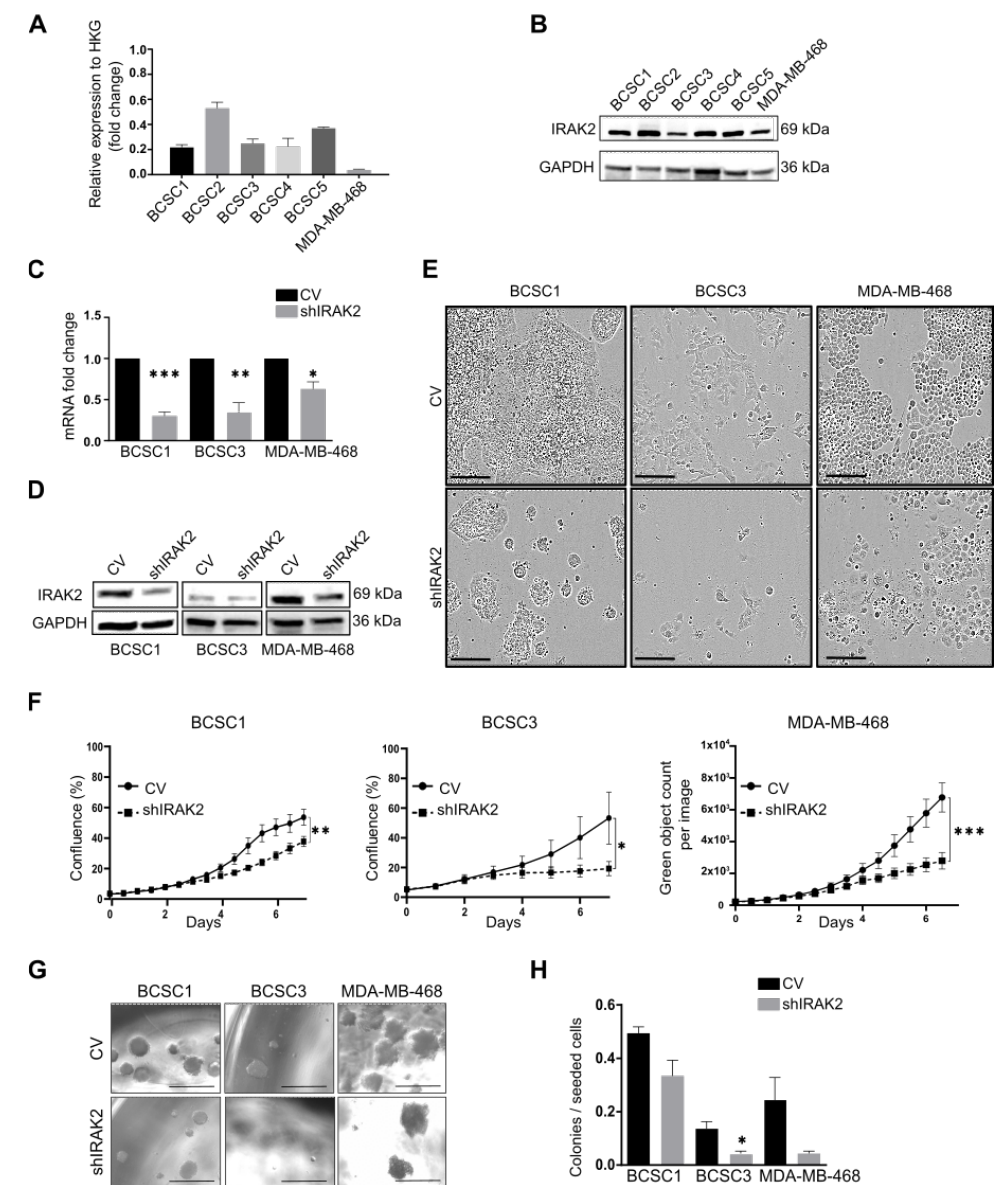
Figure 1. IRAK2 knockdown decreases the proliferation and sphere-forming capacity of BCSC1, BCSC3 and MDA-MB-468. ( A ) IRAK2 expression at the mRNA level in BCSCs and MDA-MB-468 assessed using quantitative real-time polymerase chain reaction (qPCR) analysis. IRAK2 relative ex- pression was calculated using the 2 − ∆∆ CT method and normalised to the expression of the housekeep- ing gene (HKG) hypoxanthine-guanine phosphoribosyl transferase (HPRT1). ( B ) IRAK2 expression in BCSCs and MDA-MB-468 at the protein level assessed by Western blot. ( C ) IRAK2 expression by qPCR in BCSC1, BCSC3 and MDA-MB-468 CV and shIRAK2 cells cultured for 5 days in the medium containing 100-ng/mL doxycycline. IRAK2 expression was normalised to HPRT1, and the relative expression was calculated using the 2 − ∆∆ CT method and represented as the normalised quantity of mRNA in shIRAK2 cells relative to the normalised quantity of mRNA in control cells, setting the control as 1. ( D ) IRAK2 expression was assessed by Western blot in BCSC1, BCSC3 and MDA- MB-468 CV and shIRAK2 cells cultured for 5 days in a medium containing 100-ng/mL doxycycline. ( E ) Representative images of BCSC1, BCSC3 and MDA-MB-468 phenotypes in two-dimensional